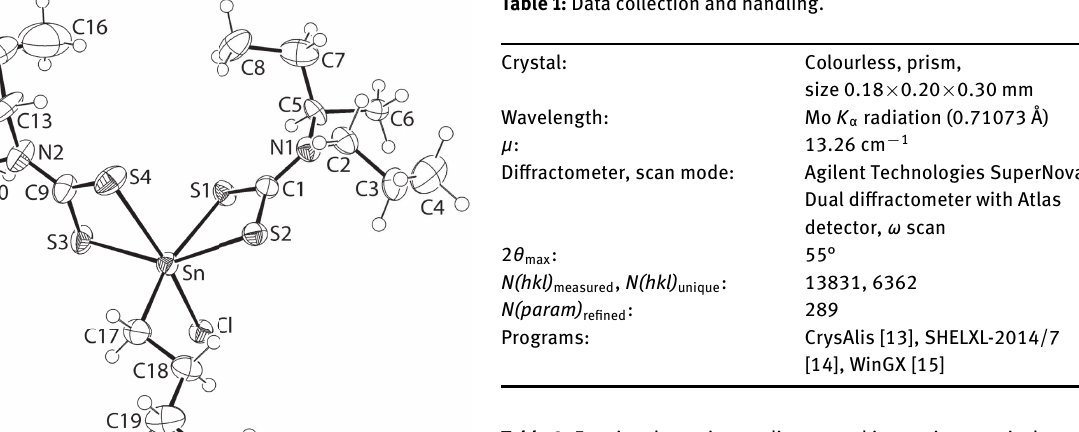
Table 2: Fractional atomic coordinates and isotropic or